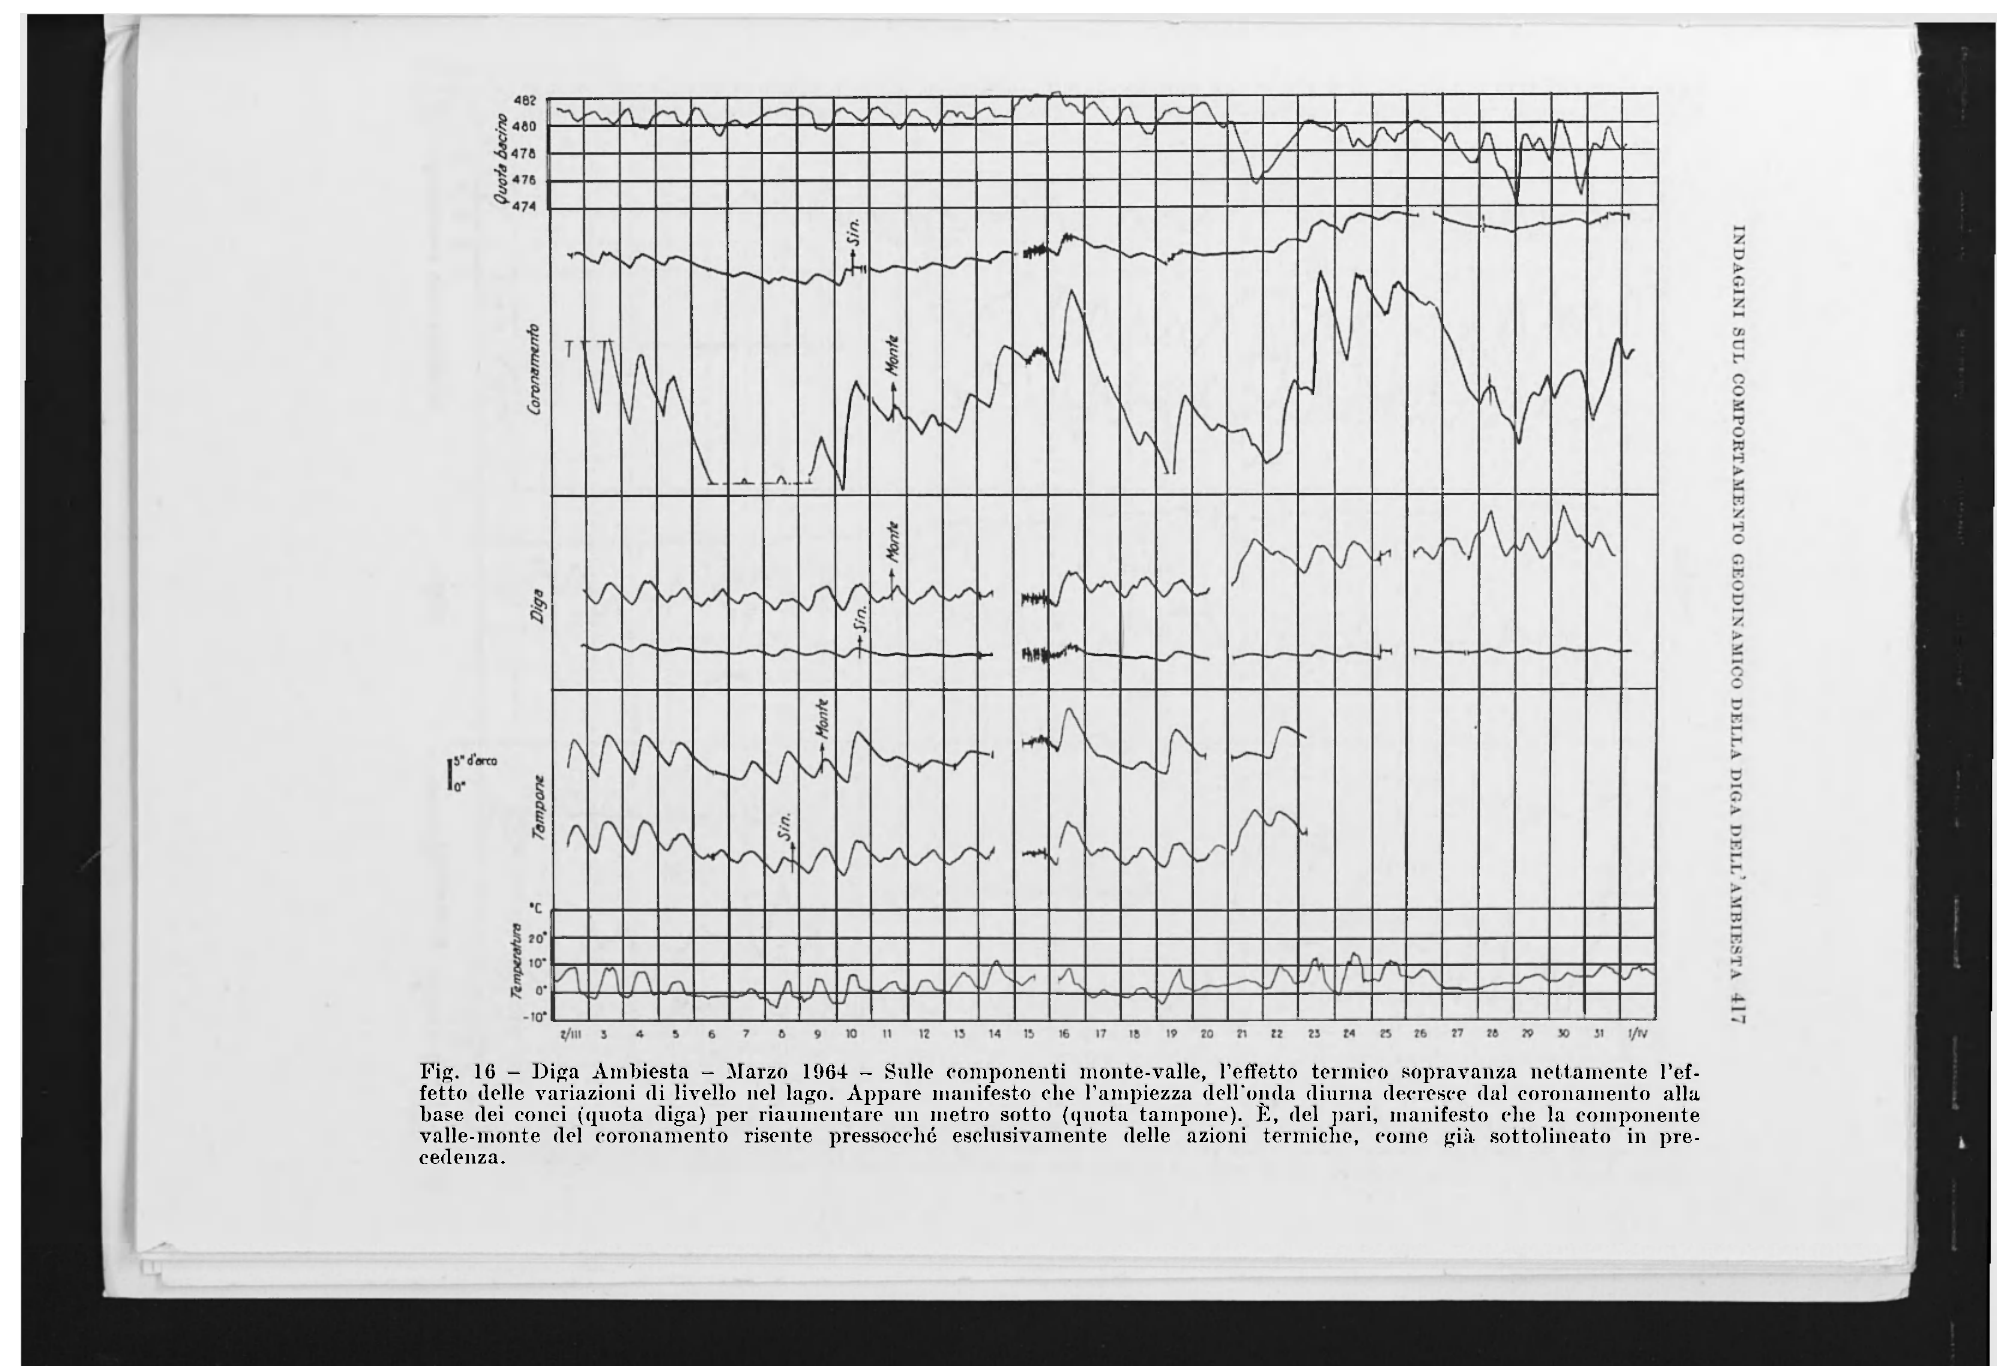
Fig. 16 - Diga Ambiesta - Marzo 1964 - Sulle componenti monte-valle, l'effetto termico sopravanza nettamente l'ef- fetto delle variazioni di livello nel lago. Appare manifesto che l'ampiezza dell'onda diurna decresce dal coronamento alla base dei conci (quota diga) per riaumentare un metro sotto (quota tampone). È, del pari, manifesto che la componente valle-monte del coronamento risente pressocché esclusivamente delle azioni termiche, come già sottolineato in pre-